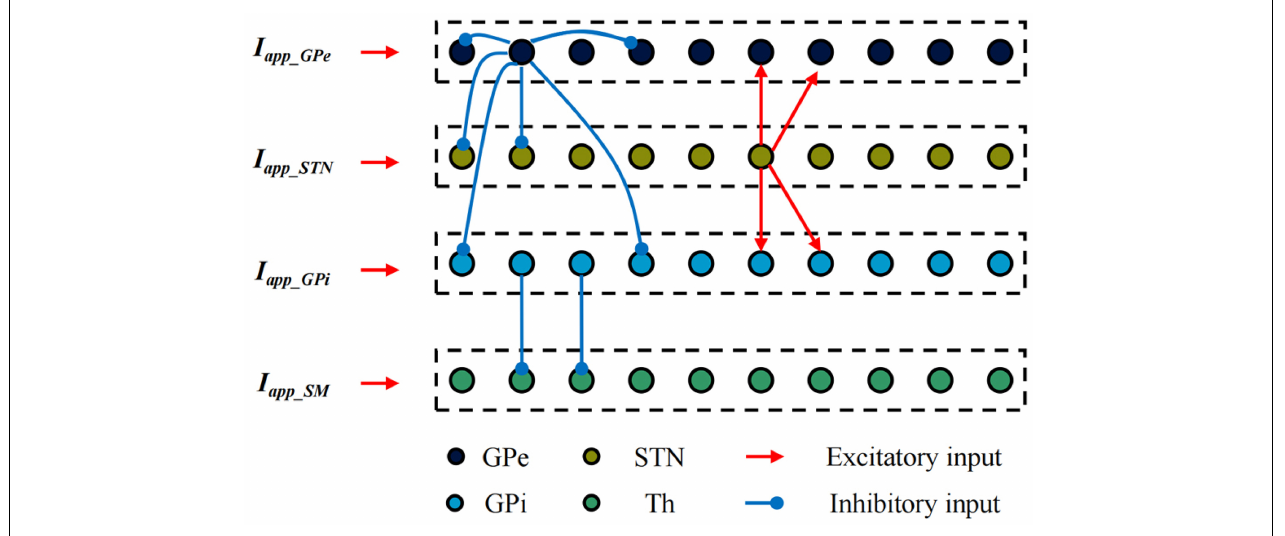
FIGURE 3 | BG-Th neural network